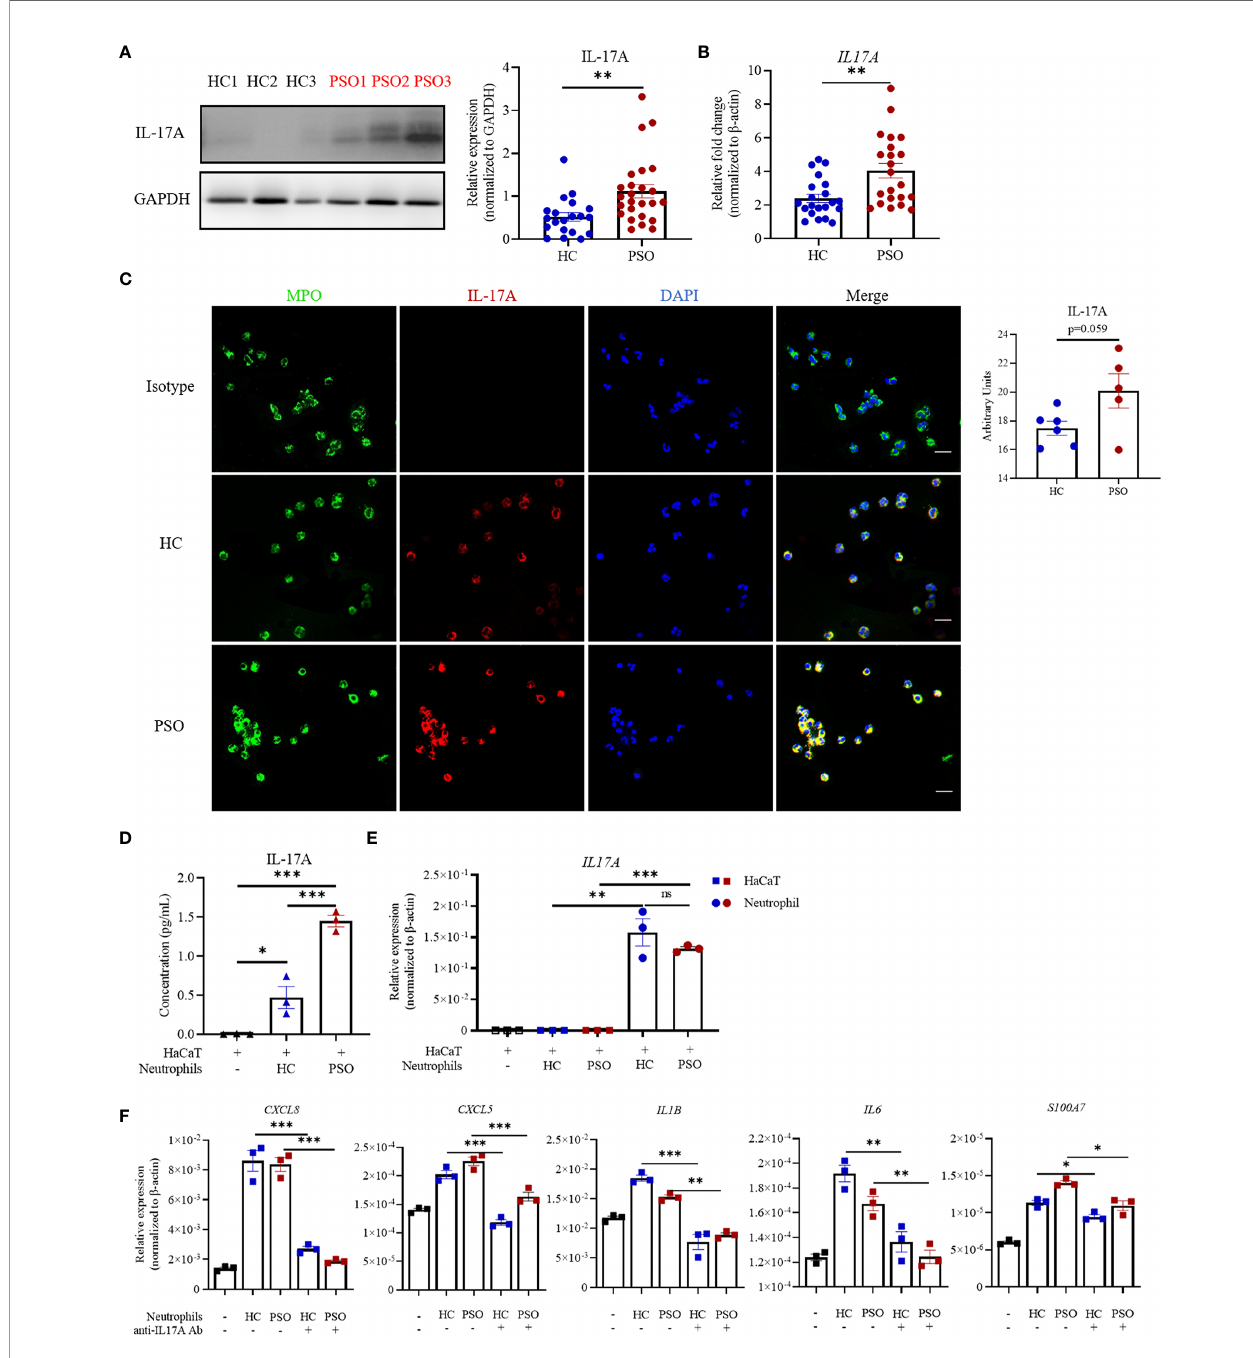
FIGURE 3 | Neutrophils promote the in fl ammatory response of keratinocytes through release of IL-17A. (A) Representative image of IL-17A expression in blood neutrophils examined by western blot (left panel) and quanti fi cation of western blot analysis from healthy controls (HC, n = 20) and psoriasis patients (PSO, n = 25) (right panel). (B) mRNA expression of IL-17A in blood neutrophils from HC (n = 21) and PSO (n = 22). (C) Representative immuno fl uorescence images of MPO (green),IL-17A (red) and DAPI (blue) expression in blood neutrophils from HC (n = 6) or PSO (n = 5), scale bar = 20 µm. Quanti fi cation analysis of IL-17A expression in neutrophils from HC and PSO. (D) Protein levels of IL-17A in the supernatant determined by ELISA at 8 h from coculture system of HaCaT alone, HaCaT plus healthy neutrophils or HaCaT plus psoriatic neutrophils. (E) mRNA expression of IL-17A in HaCaT cells stimulated by neutrophils (square) and in neutrophils (circle) from psoriasis patients. (F) mRNA expression of in fl ammatory mediators in HaCaT 8 h after directly coculture with neutrophils with and without anti-IL-17A Abs (12.5 m g/ml). Data are representative of three or more independent experiments. Data are presented mean ± SEM and analyzed by the two-tailed Student ’ s t -test or one- way ANOVA. *p < 0.05; **p < 0.01; ***p < 0.001; Abs, antibodies; ns, not signi fi